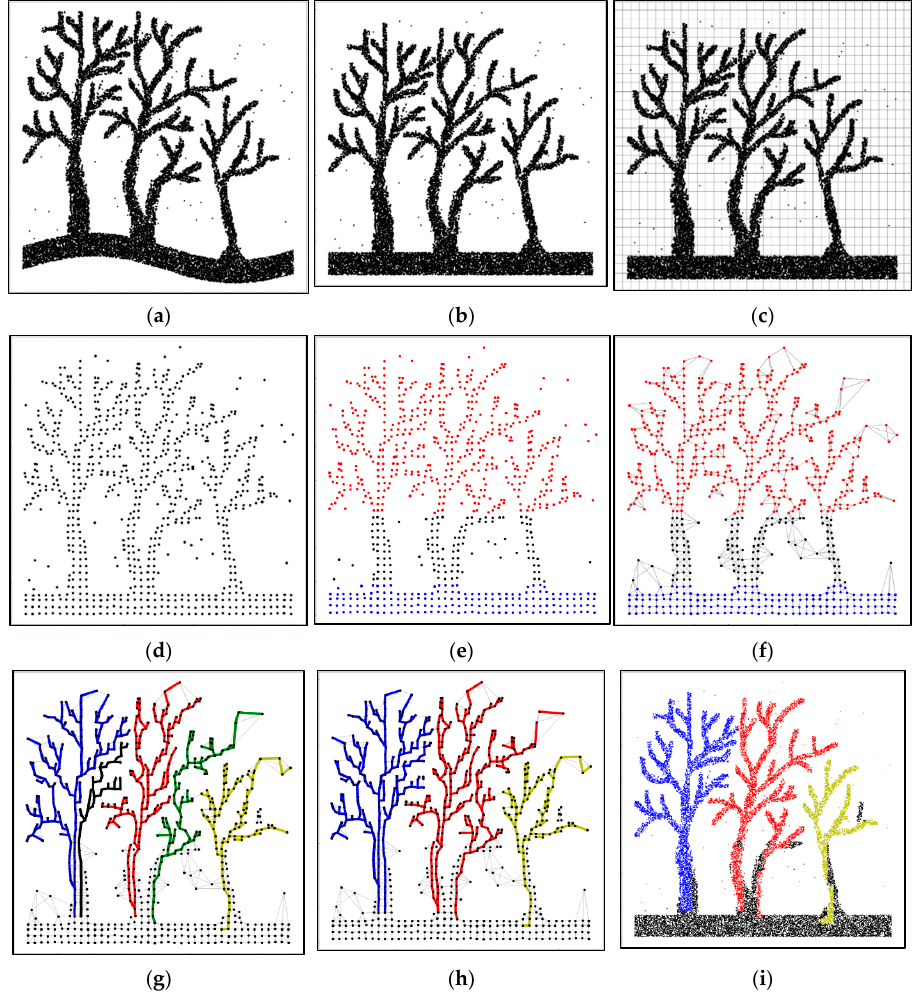
Figure 3. A 2D example showing the various stages of the of the tree segmentation algorithm presented in this paper. ( a ) The raw input point cloud. ( b ) The normalized input point cloud before superpoint encoding. ( c ) Visualization of the voxel divisions for superpoint encoding. ( d ) Results of superpoint encoding. ( e ) Results of rough classification. Red indicates ‘canopy’ superpoints, blue indicates ‘ground’ superpoints, and black indicates unlabeled superpoints. ( f ) Superpoints with a connectivity graph. In this toy example, k = 3. ( g ) Tree sets (distinguished by color) built by least-cost routing. ( h ) Three trees (blue, red, green, yellow) formed by grouping tree sets. ( i ) Mapping the tree labels back to the original point cloud points.